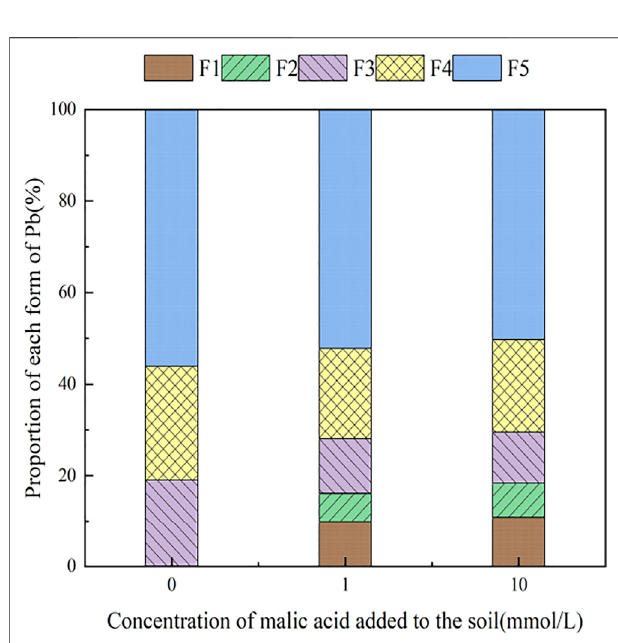
FIGURE 7 | The distribution of Pb form in the original soil after adding malic acid.